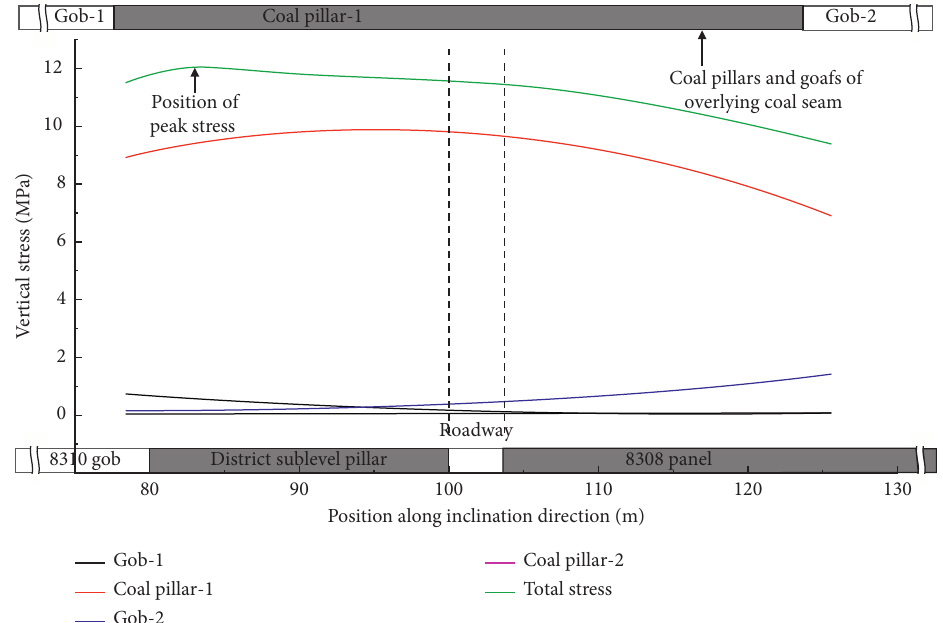
Figure. 12: Stress distribution of overlying coal pillars and goaf areas in 11–2# coal seam.